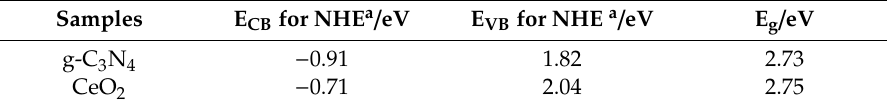
Table 2. Energy band engineering analysis of g-C 3 N 4 and CeO 2 .